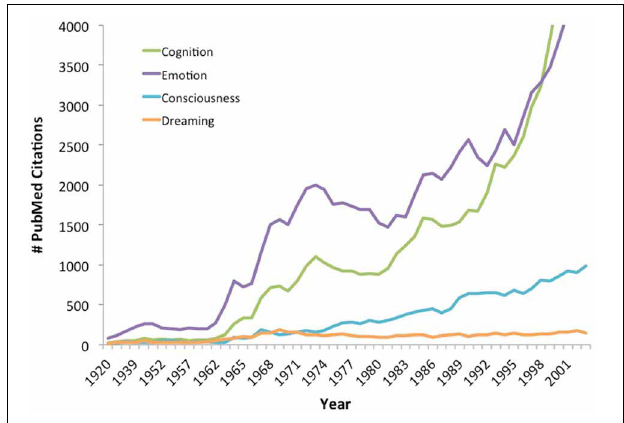
FIGURE 1 | The cognitive revolution has overlooked sleep. The cognitive revolution set off a research boom into a variety of long-neglected topics dealing with subjective experience during wakefulness, yet conscious experience during sleep and dreaming have not been targets of a comparable research surge. Counts represent the number of PubMed citations containing the keywords “cognition,” “emotion,” “consciousness” or “dreaming” (within all database fields and MeSH terms) for each year 1920–2003. The search for “dreaming” also included citations containing the MeSH term “dreams.” Both research articles and reviews are included in the citation